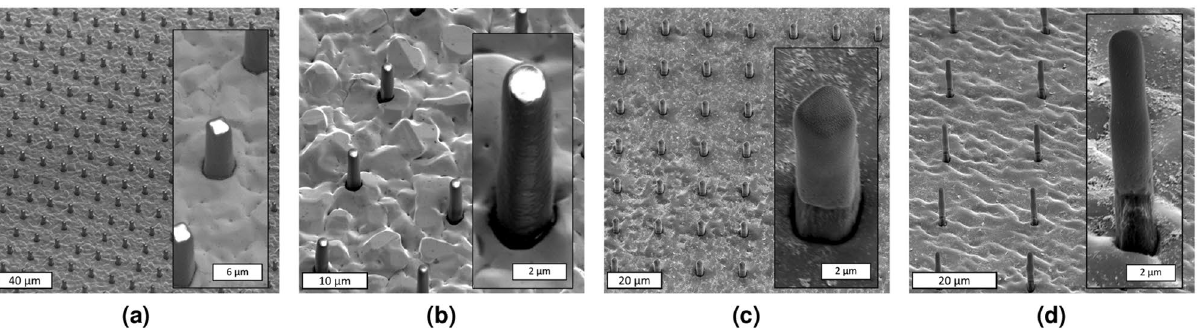
Figure 6. SEM images of the second SU-8 layer in various feature sizes of SU-8 micropillar-based gratings. A successful pattern transfer from the first SU-8 layer to the second one is evident in all samples, with ( a, b ) being the SU-8 micropillars sufficiently electroplated, and ( c, d ) being the SU-8 micropillars underplated. gold thickness for the prototype three-layer X-ray grating was around 40 µ m —an aspect ratio of around 10:1. Figure 7a demonstrates the 70mm × 70mm prototype grating mounted on an aluminum holder for easier han- dling. The transmission image at 60kV p of a two-layer and a three-layer version of the 70mm × 70mm proto- type grating is presented in Fig. 7b, c, respectively, along with a cross-sectional profile across the dashed blue line in each image representing the corresponding grating transmission value and its uniformity. Table 1 summarizes the specifications of the two-layer and the three-layer version of the 70mm × 70mm prototype gratings. X‑ray phase‑contrast imaging setup.